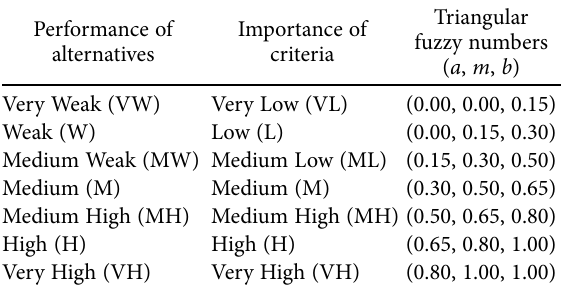
Table 2. Linguistic definition for importance weight of